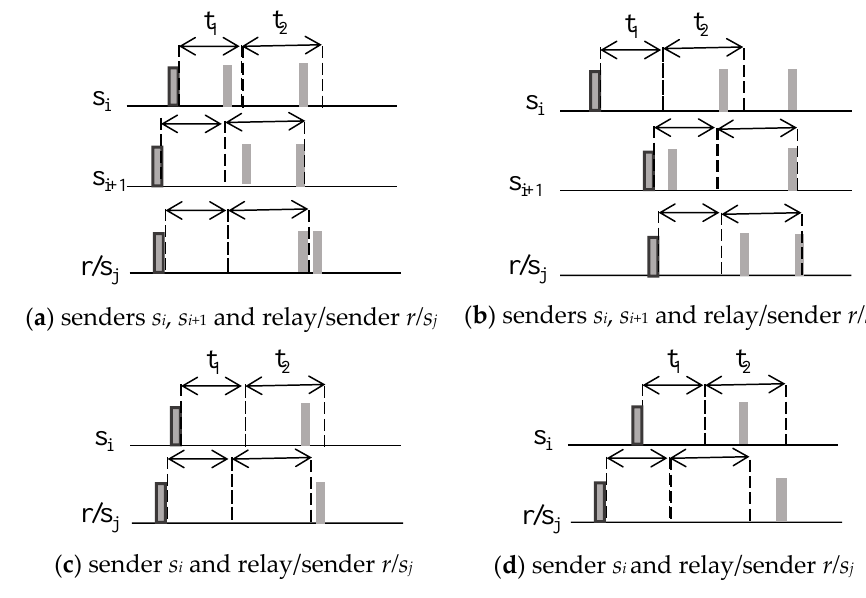
Figure 5. Special cases not covered by Algorithm 1.